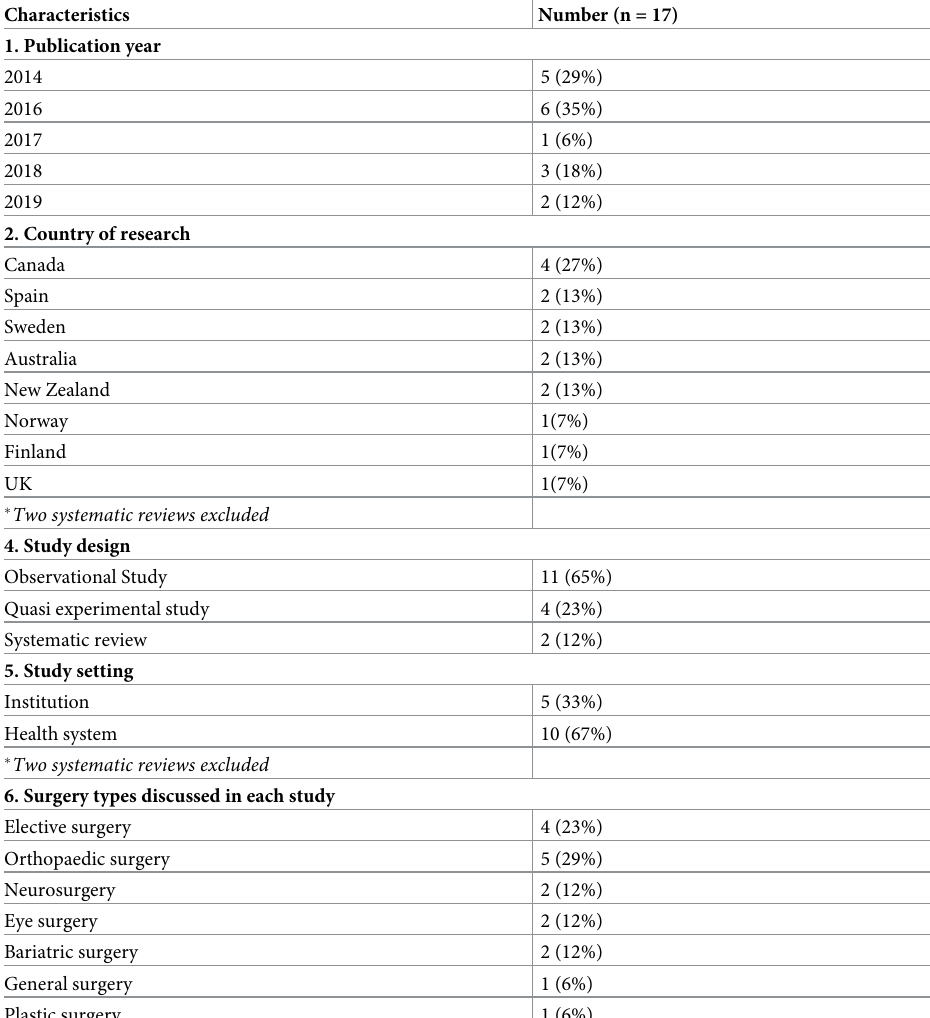
Table 1. Summary of characteristics in included